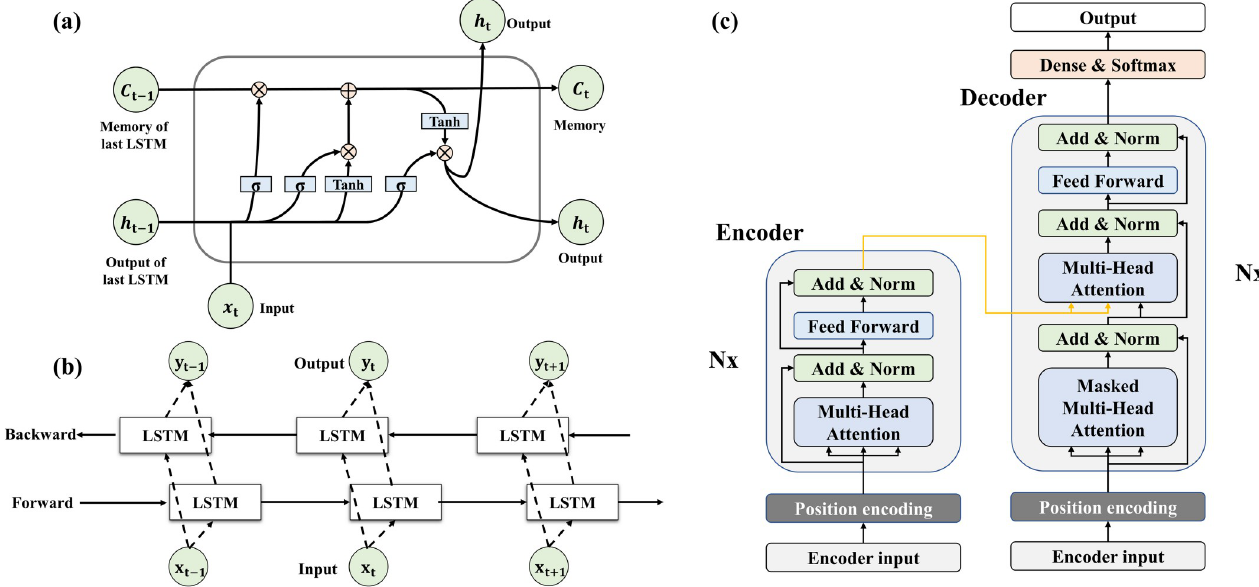
Fig 2. Network structures of the deep learning models used for respiration prediction. (a) Long-short term memory (LSTM): calculation using a forget gate based on RNN, (b) Bidirectional-LSTM: calculations using LSTMs in the backward and forward directions, (c) Transformer: iteratively computes N encoders and